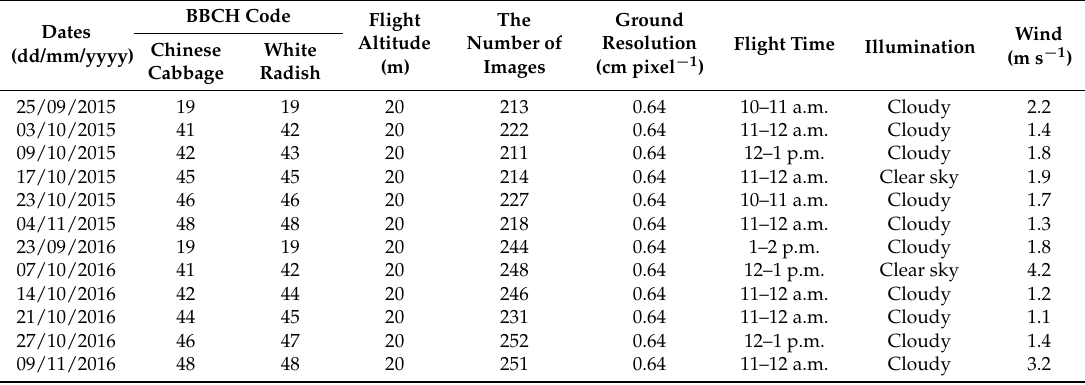
Table 2. UAV imaging details and Biologische Bundesanstalt, Bundessortenamt und CHemische Industrie (BBCH) codes of Chinese cabbage and white radish used in 2015 and 2016 field